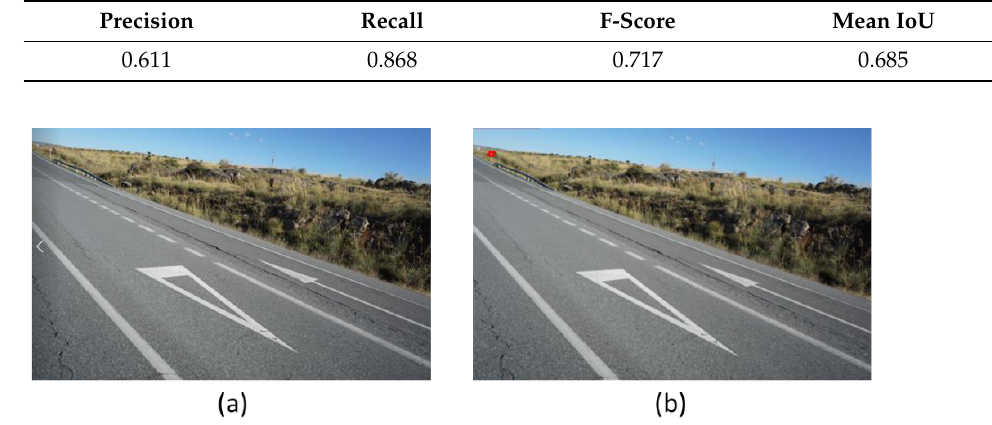
Figure 11. Example of an extreme situation where ( a ) Traffic sign is omitted by the manual labeller. ( b ) Traffic sign is detected by the deep learning architecture.